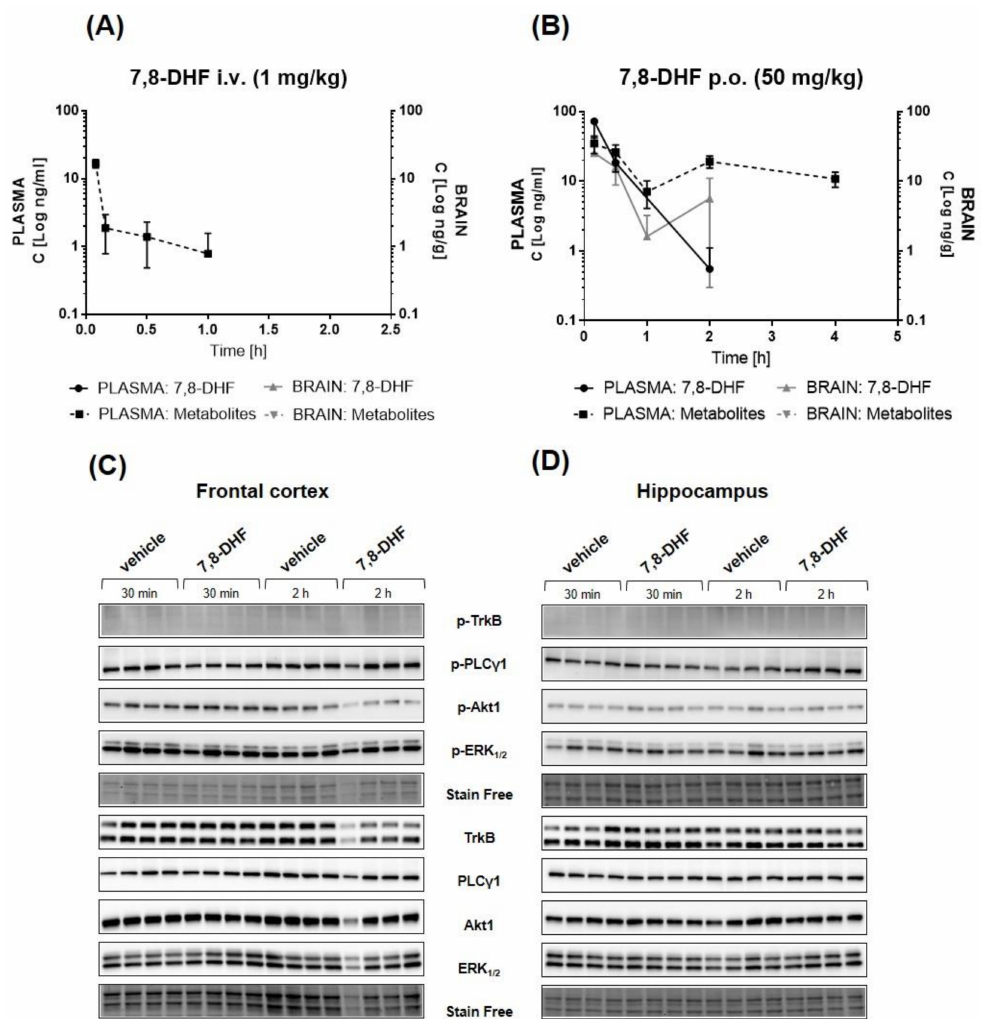
Figure 8. Pharmacokinetic and pharmacodynamic profiles of 7,8-DHF in BALB/c mice. The concentration–time curve of 7,8-DHF and its metabolites (7-hydroxy-8-methoxyflavone and 8-hydroxy-7-methoxyflavone) in plasma and brain lysates after intravenous ( A ) and oral ( B ) administration. Data are expressed as mean ± SEM, n = 4. Western blot analysis of the phosphorylation of TrkB and selected downstream proteins in the frontal cortex ( C ) and hippocampus ( D ) after oral administration of